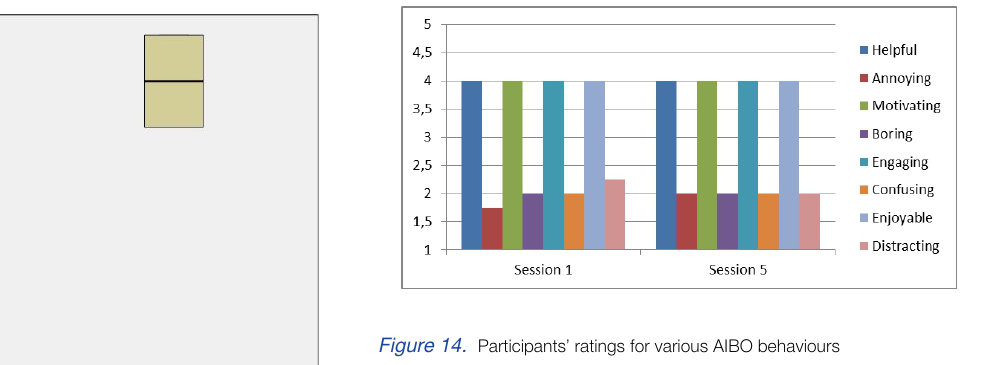
Figure 14. Participants’ ratings for various AIBO behaviours